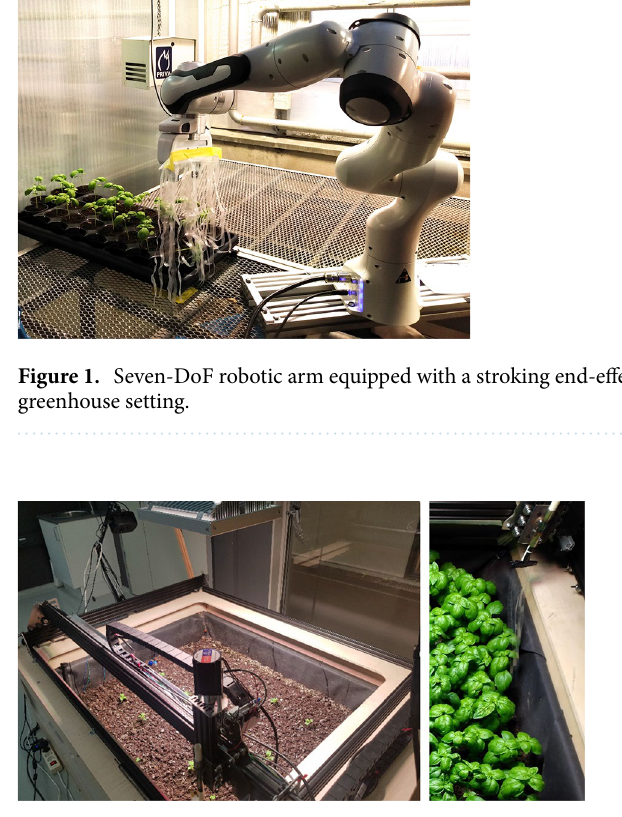
Figure 2. LOMAS++ cultivation testbed equipped with three-DoF robotic manipulator and a stroking plastic end-effector for mechanical stress induction. Left: the growing bed. Right: the stroking